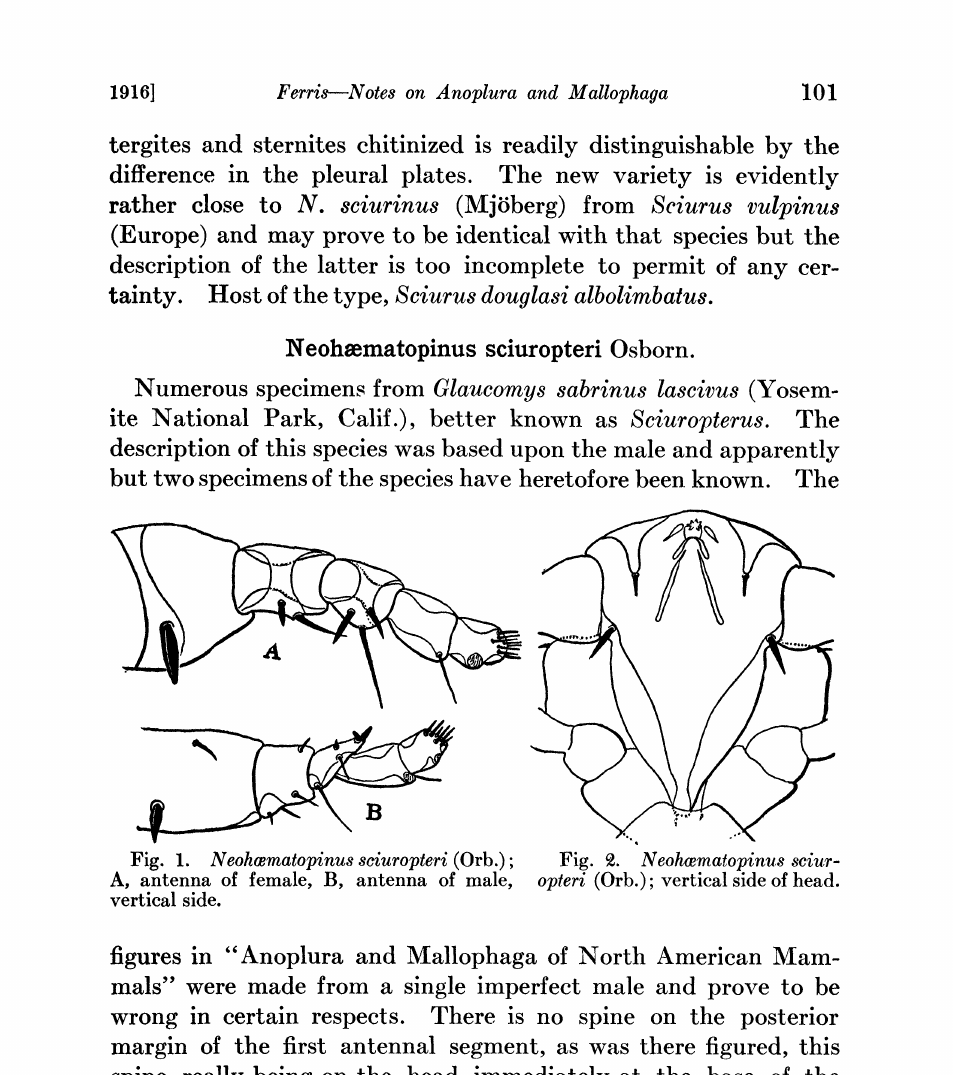
"Neohaematopinus sciur-